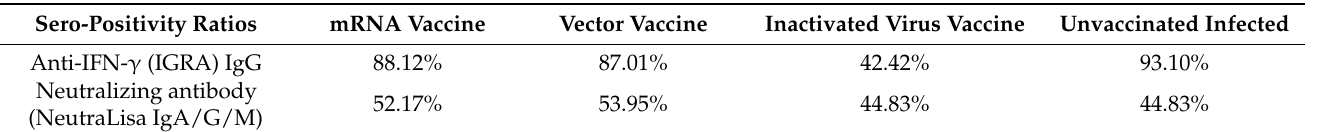
Table 2. Cellular response (Anti-IFN- γ ) and neutralizing antibody positivity ratios elicited by different vaccines.